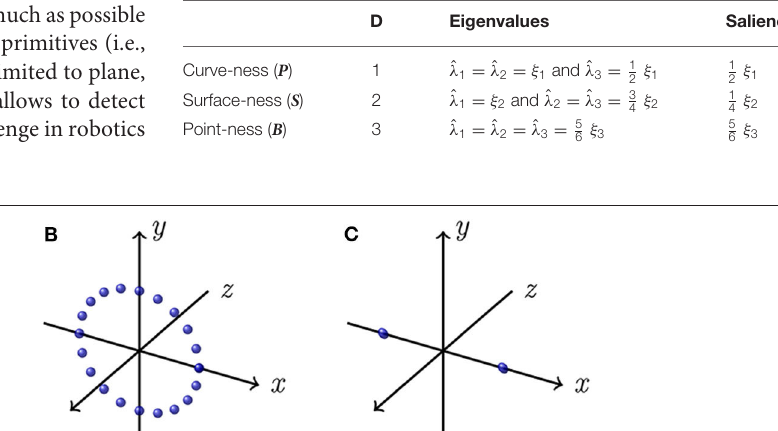
Frontiers in Robotics and AI |